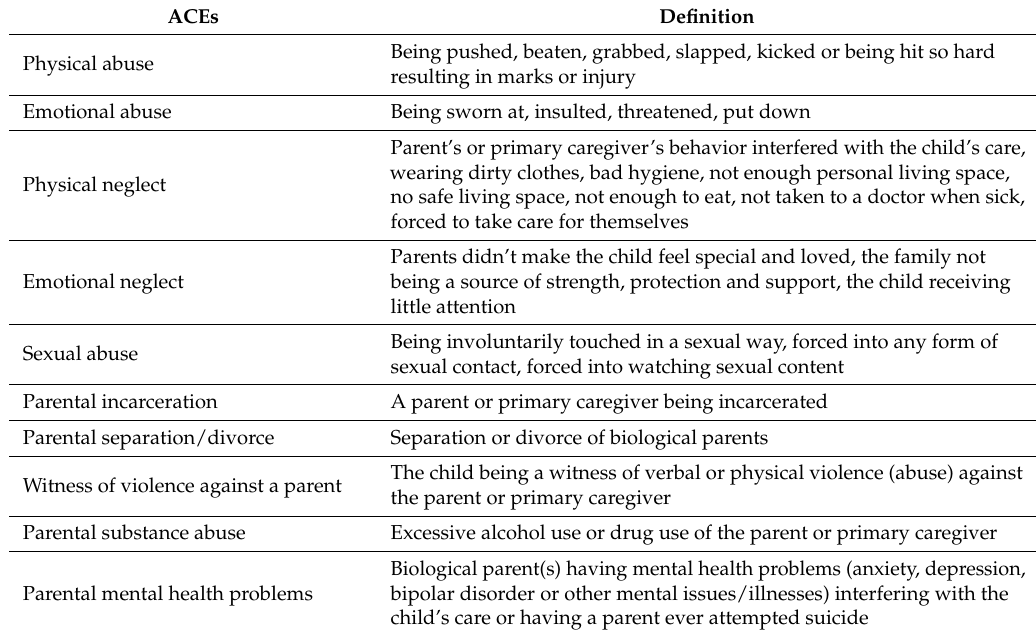
Table 2. Overview and definition of the original ACEs (Adverse Childhood Experiences) framework used in the present